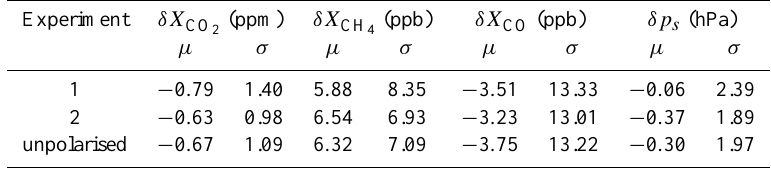
Table 2. Means ( µ ) and standard deviations ( σ ) of the biases δX CO pressure from the two experiments. The row labelled “unpolarised” contains reference results obtained for an instrument equipped with ideal polarisation scramblers.